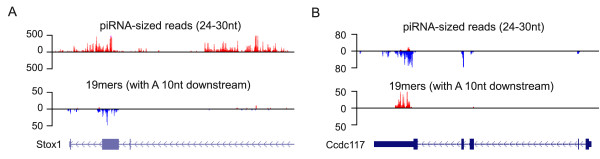
Genes overlapped by piRNAs and 19mers (A) A piRNA cluster, transcribed from left to right and overlapped by a gene transcribed in the opposite direction, is presented (NCBI37/mm9 locus: chr10:62,120,321-62,152,434). The coverage of piRNA-sized reads (24-30nt) and 19mers (with A 10 nt downstream) is also presented in the form of wiggle plots with reads mapped from left to right above the x-axis and reads mapped from right to left below. Only uniquely mapping reads were used. The position of a gene (Stox1) is indicated with exons represented by filled boxes, arrows indicating the direction of transcription and the thin boxes representing the untranslated regions (UTRs). (B) A gene giving rise to piRNAs and and opposite sense 19mers is presented (NCBI37/mm9 locus: chr11:5,428,021-5,442,615). The coverage of piRNAs-sized reads (24-30nt) and 19mers (with A 10 nt downstream) is plotted in the form of wiggle plots with reads mapped from left to right above the x-axis and reads mapped from right to left below. Only uniquely mapping reads were used. The position of the gene (Ccdc117) is indicated with exons represented by filled boxes, arrows indicating the direction of transcription and thin boxes representing the UTRs.